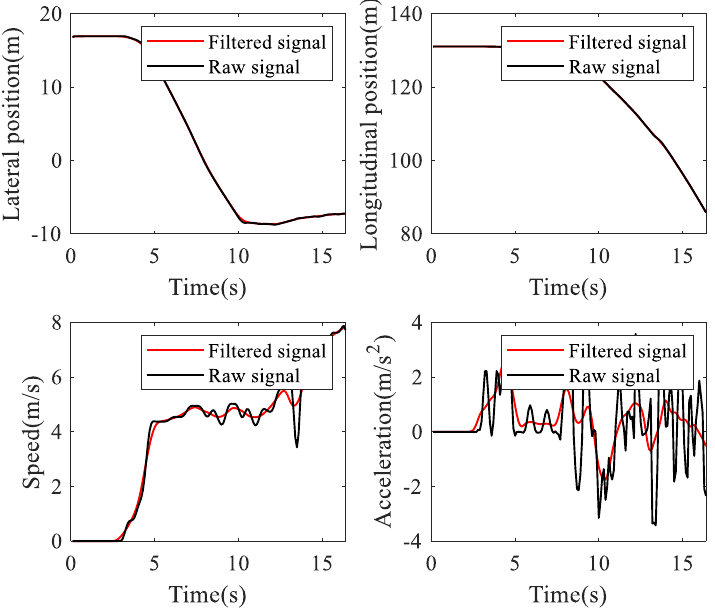
Figure 8. The process of entering the intersection.